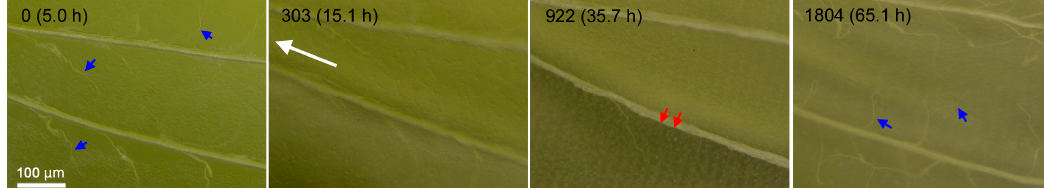
Figure 7. The M 3 compartment dynamics in the dorsal hindwing. The postpupation time is indicated together with panel numbers. Images were taken every 2 min. Moving branching tracheae and tracheoles (blue arrows) and aligned scale arrays (red arrows) are indicated. The direction of tracheal movement to the base is indicated by a long white arrow. See also Video S4.